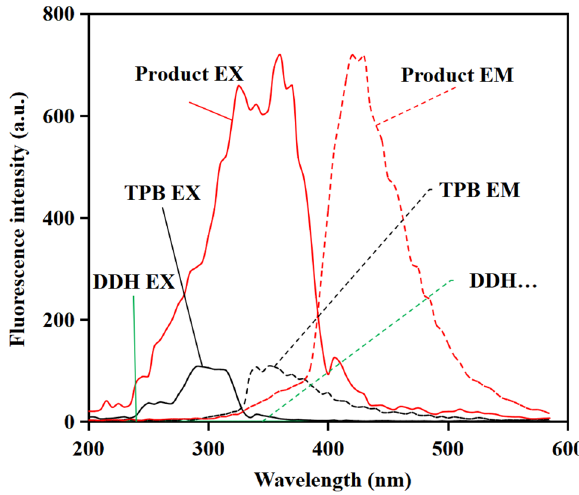
Figure 3. Comparison of fluorescent excitation (EX) and emission (EM) spectra of DDH (0.006 mmol L −1 ), TPB (0.006 mmol L −1 ) and the product (0.01 mg L −1 ). Excitation wavelength: 200–600 nm, Emission wavelength: 200–600 nm.